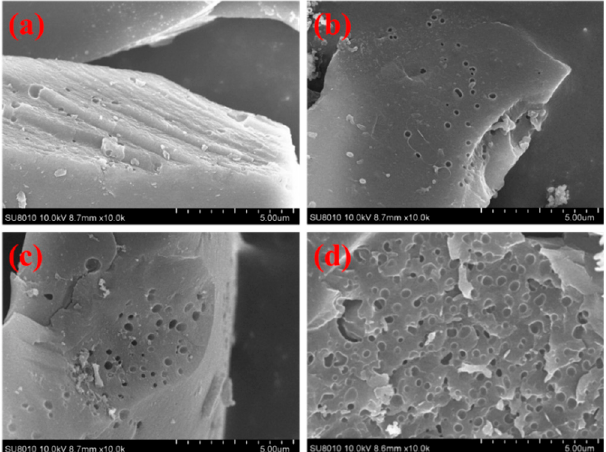
Figure 1. Scanning electron microscope (SEM) images of the NPC-500 ( a ); HPC-600 ( b ); HPC-700 ( c ); and HPC-800 ( d ).